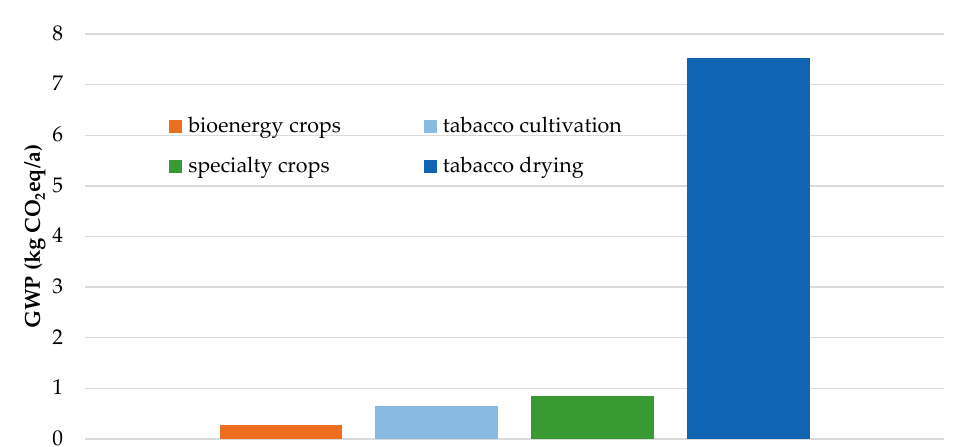
Figure 9. Global warming potential (GWP) of raw material supply for extraction, based on data from [64–66].